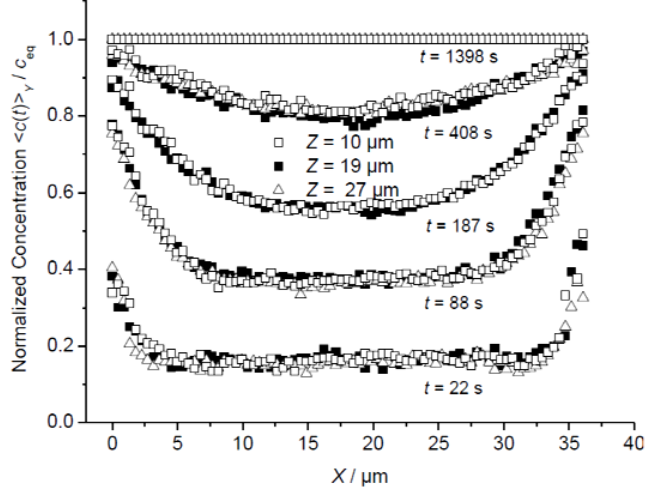
Figure 2. Comparison of the evolution of the profiles of mean intracrystalline concentration perpendicular to the XZ plane (mean concentrations in Y direction), in X direction, at different locations Z ( , , , see Figure 1b, scheme 1) during molecular uptake of methyl-butane in